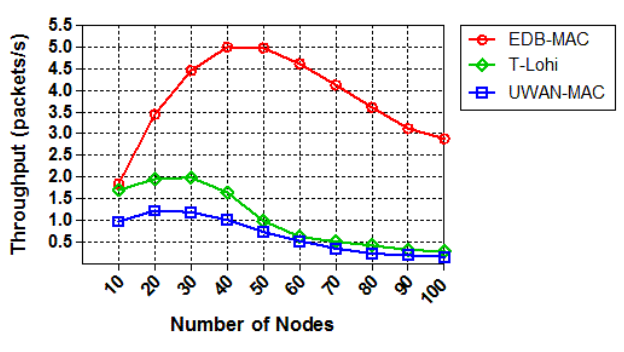
Figure 14. Throughput vs. node